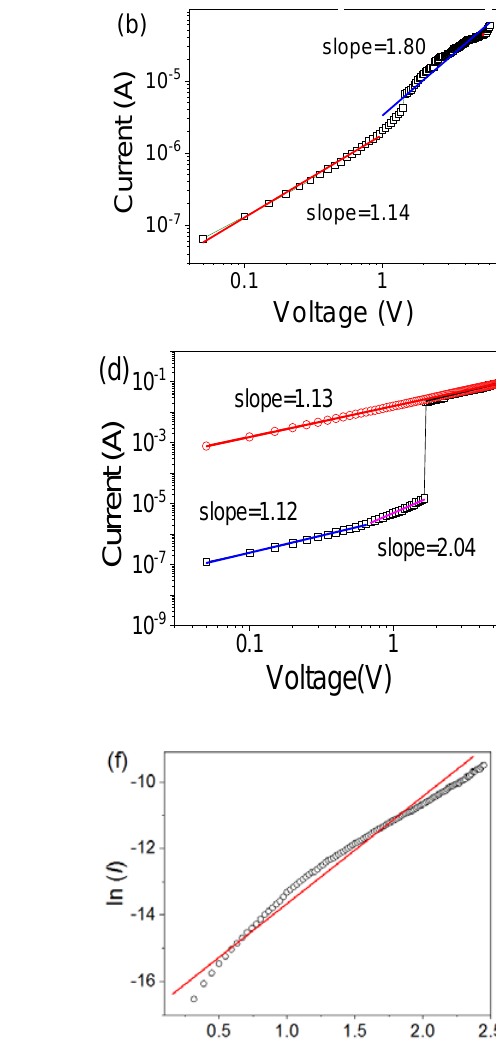
Figure 6. The log( I ) µlog( V ) plots with the Co–Al LDH memristor for space charge-limited conduction fitting for ( a ) HRS and ( b ) LRS. The log( I )µlog( V ) plots for space charge-limited conduction fitting for the Co–Al LDH-adsorbed hexazinone memristor. ( c ) The negative voltage region. ( d ) The positive voltage region. The ln( I )µ V 1/2 relationship fitting in HRS for ( e ) the Co–Al LDH memristor and ( f ) the Co–Al LDH-adsorbed hexazinone memristor.